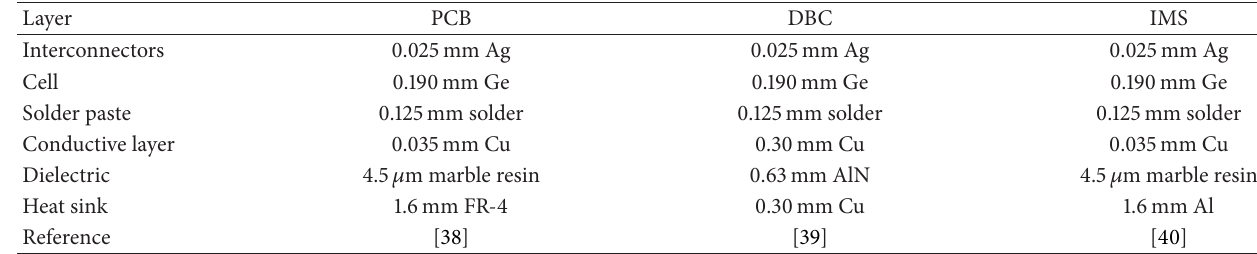
Table 3: Thicknesses and materials for the modelled substrates.